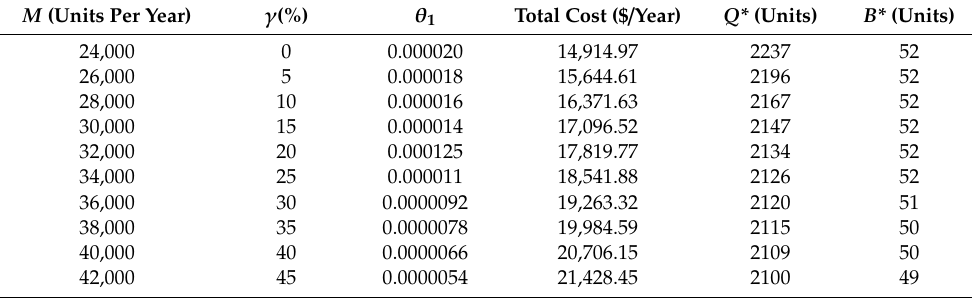
Table 5. Change in optimal lot size and backorder quantity with variation in the defective rate and inspection rate (Example